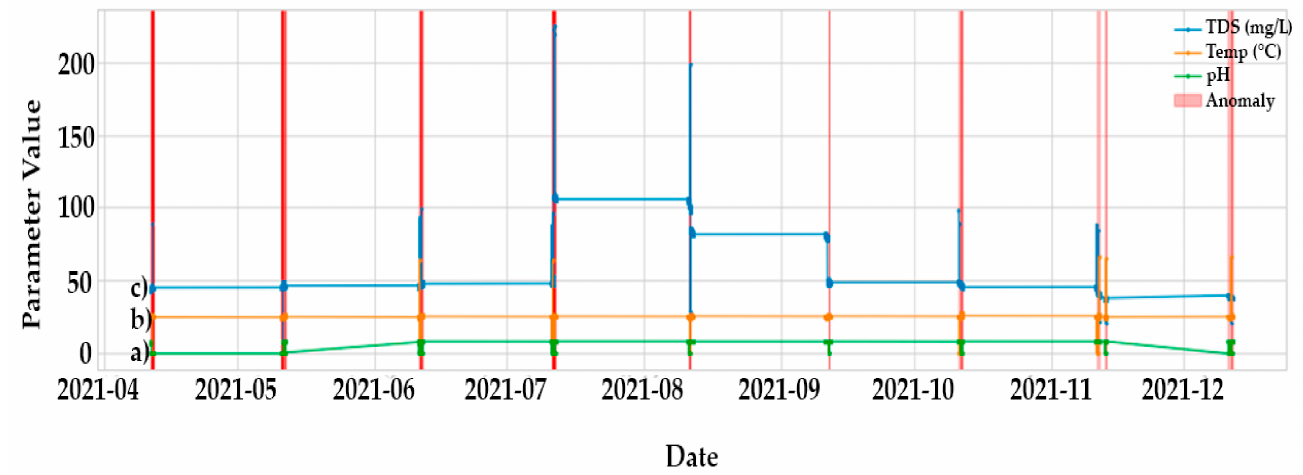
Figure 6. The graphical output of the anomaly detection module integrated with IoT-WQSM. Anomaly monitoring of ( a ) pH (lower green line), ( b ) temperature (middle orange line), ( c ) total dissolved solids (TDS, upper blue line), detected anomalies (red vertical